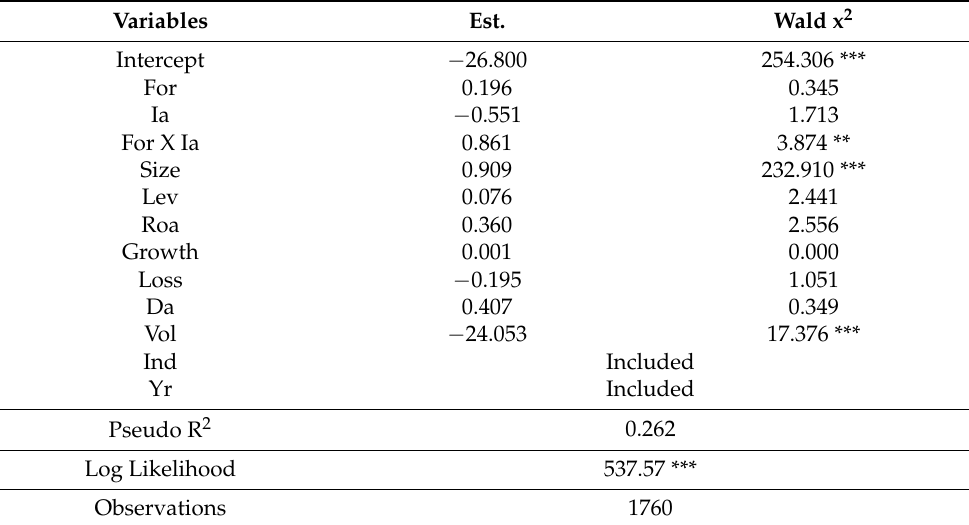
Table 8. The effect of information asymmetry on the relationship between foreign investors and voluntary